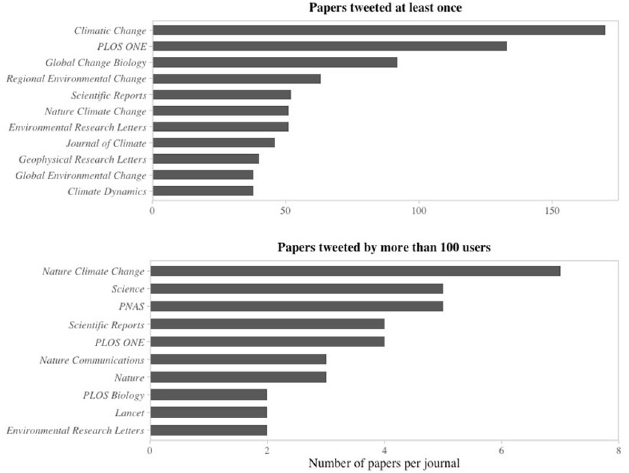
Fig 1. Distribution of climate change research tweeted papers in scientific journals. Depicted in the above histogram are the ten journals that published the most tweeted papers in our dataset, and below are the ten journals that published the most papers tweeted by more than 100